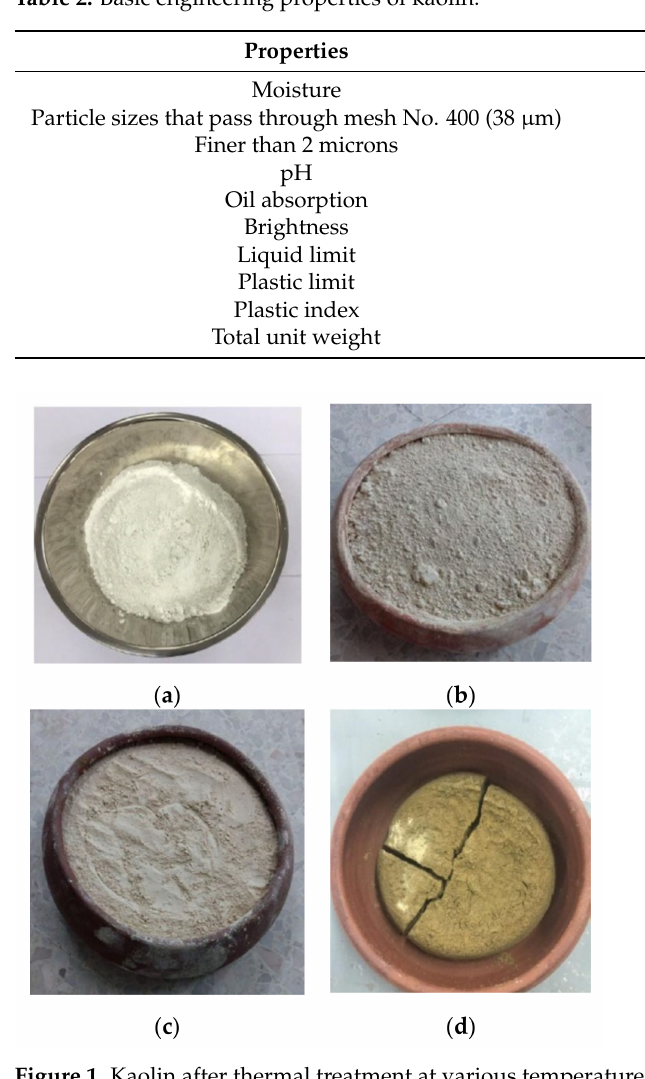
Table 2. Basic engineering properties of kaolin.